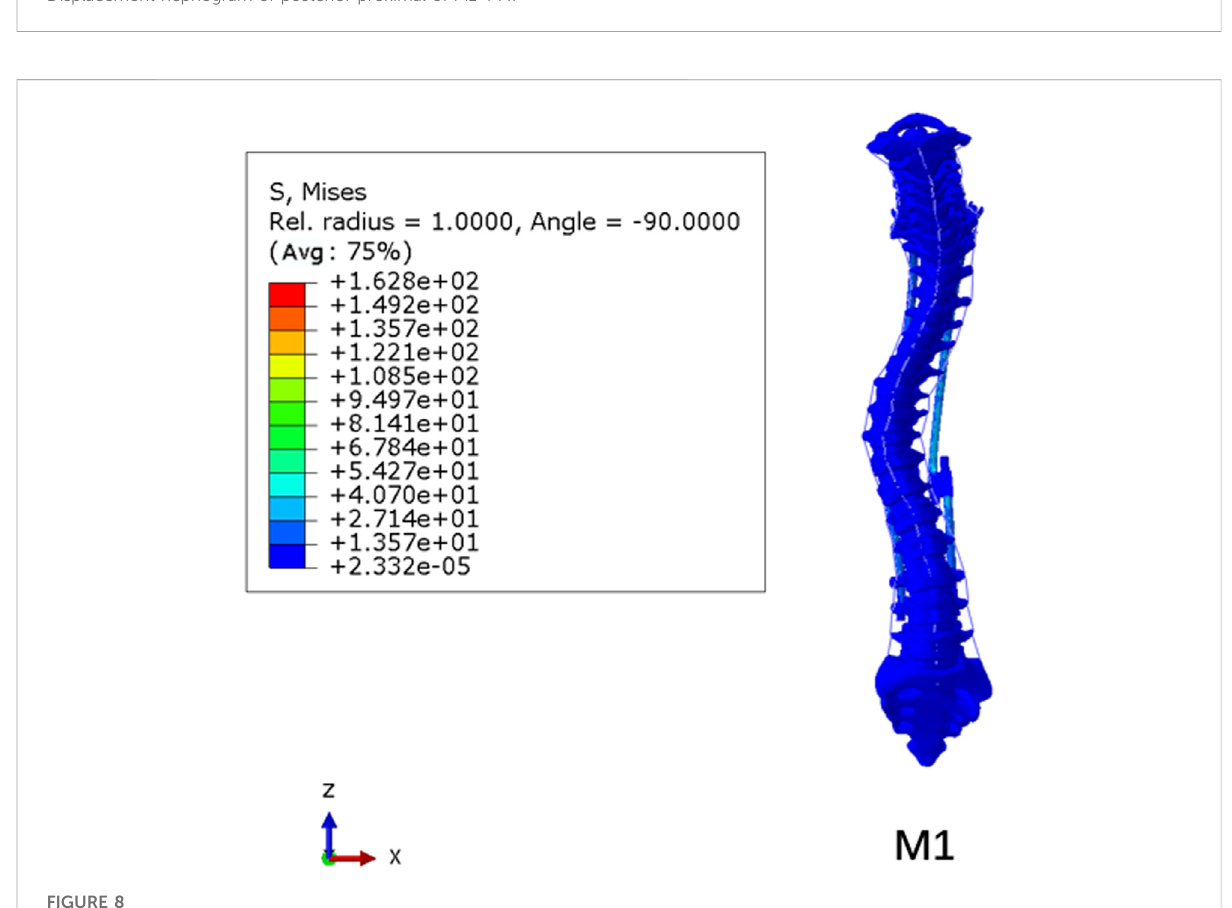
FIGURE 8 Stress nephogram of M1